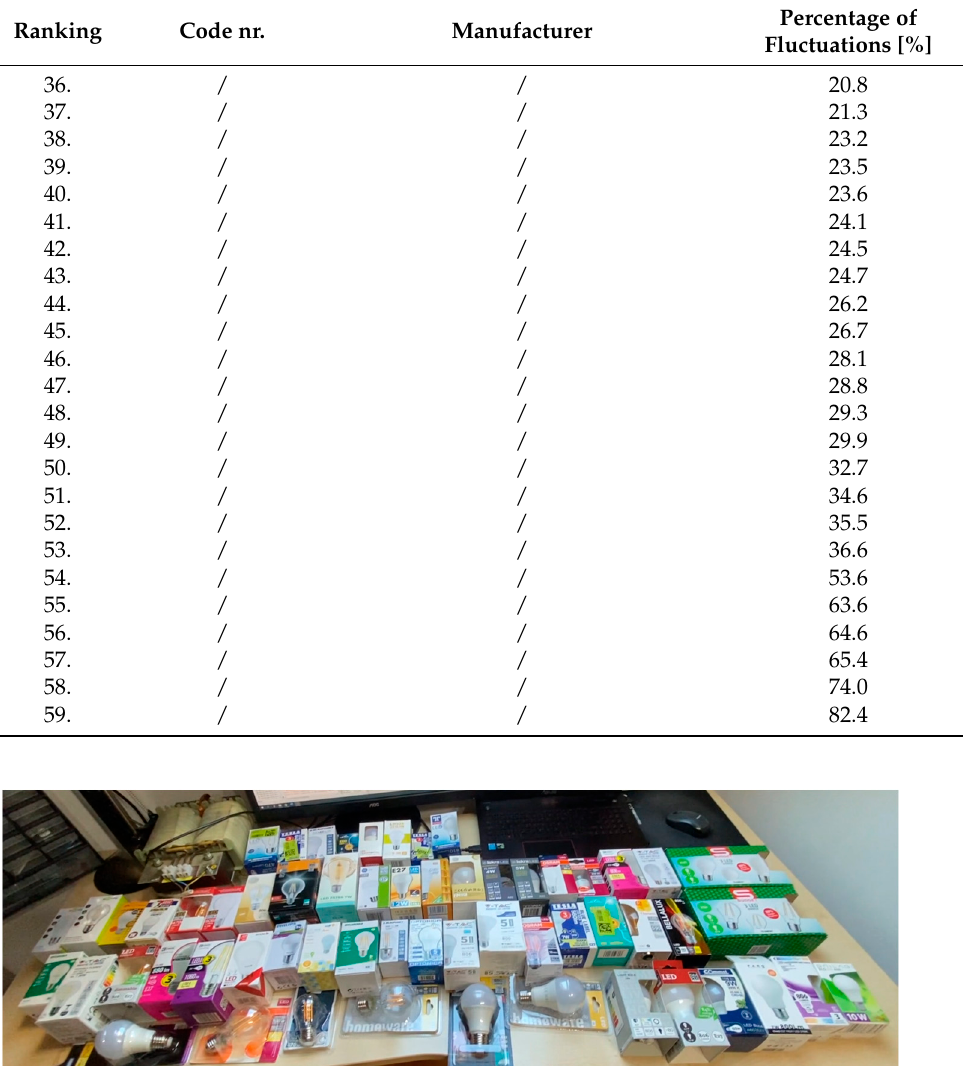
Table 2. Classification of LED light bulbs based on the percentage of fluctuations in the luminous flux.